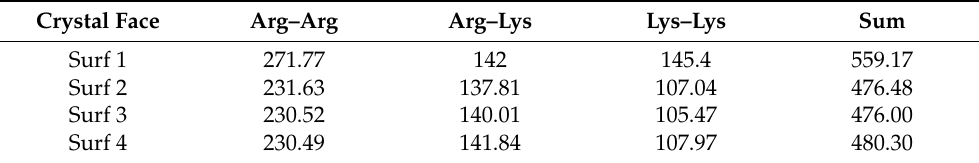
Table 2. Direction-dependent theoretical crystal strength due to the anisotropic cross-linking bonds between three residual pairs: arginine–arginine, arginine–lysine, and lysine–lysine. Surf 1 is the basal face, and Surf 2–3 are the three prismatic faces. Reprinted with permission from [31]. Copyright (2019) American Chemical